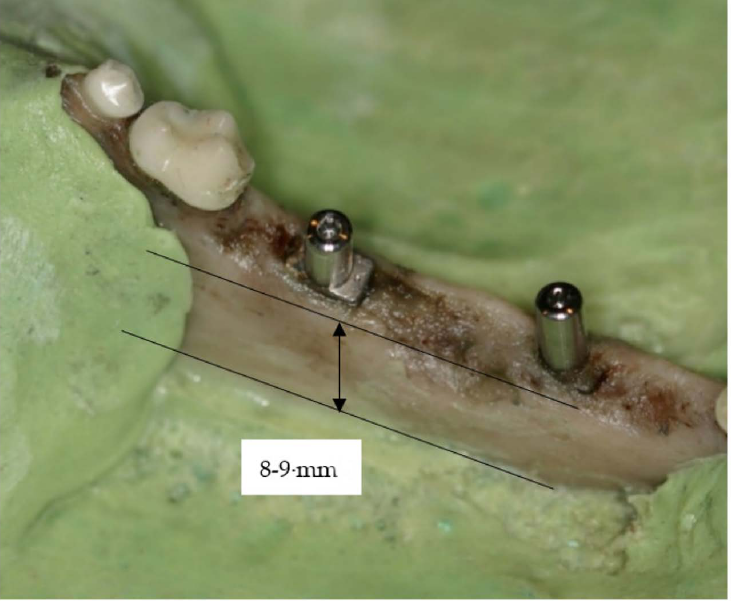
Figure 1. Embedded half mandible in acrylic, leaving the exposed alveolus and integrated implants. The embedment of the bone was limited so as to expose the entire implanted